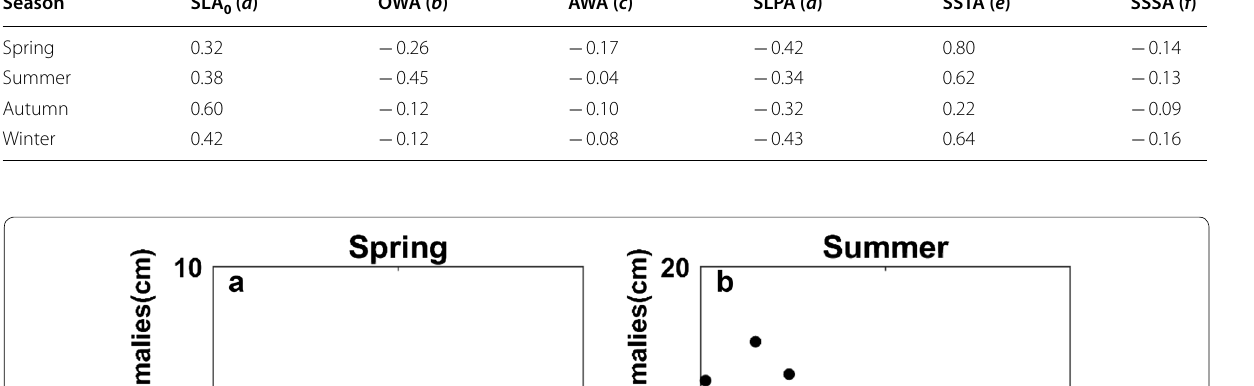
Table 3 Coefficients of linear regression of normalized SLA Season